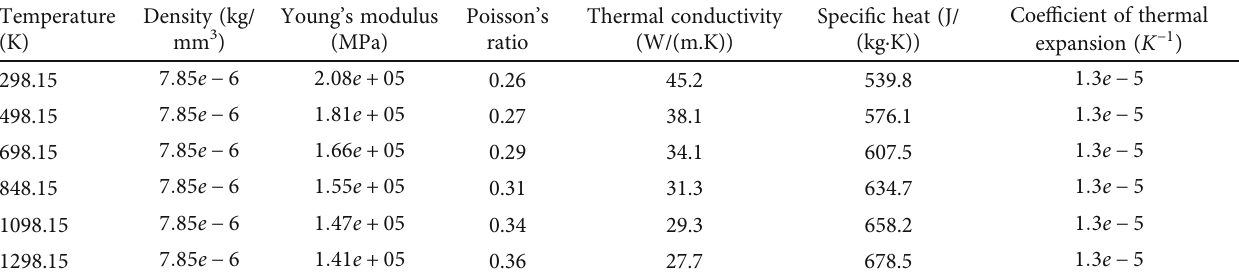
Table 2: Parameters of the barrel substrate material.